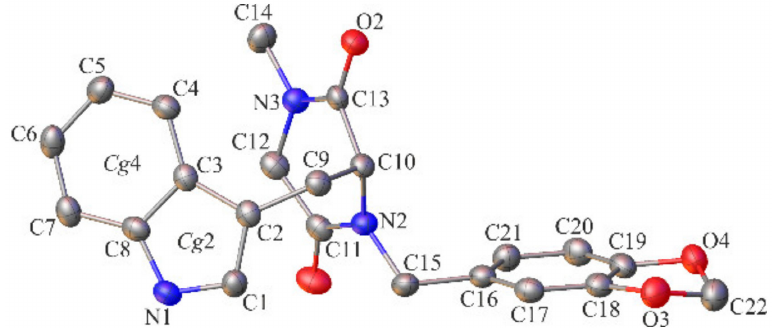
Figure 6. Asymmetric unit of the crystal lattice of 6a with crystallographic numbering. Displacement ellipsoids are drawn at the 50% probability level and the H-atoms were omitted for clarity. Cg 2 and Cg 4 denote the geometric centres of gravity of the aromatic rings delineated by the N1/C1–C3/C8 and C3–C8 atoms,